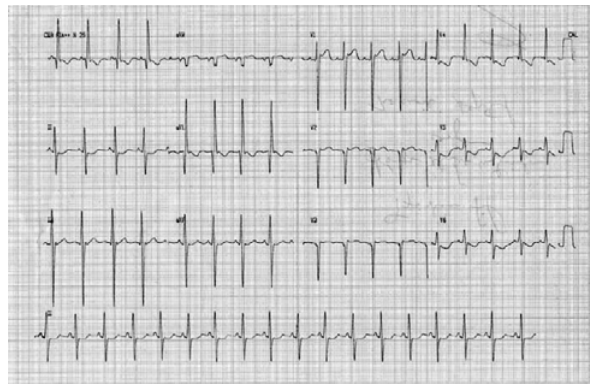
Fig. 1 – Eletrocardiograma demonstrando características de origem anômala de artéria coronária da artéria